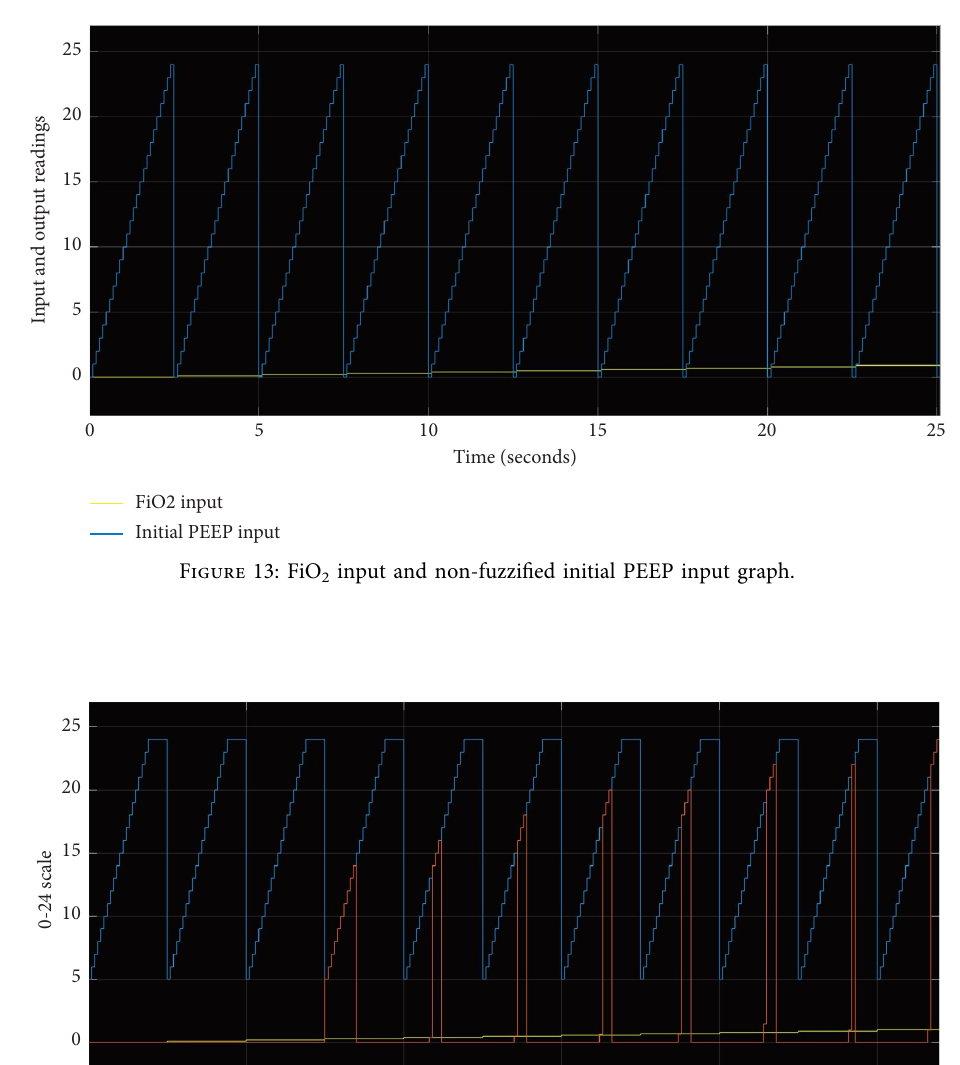
2 (yellow in colour) and general range of PEEP (blue in